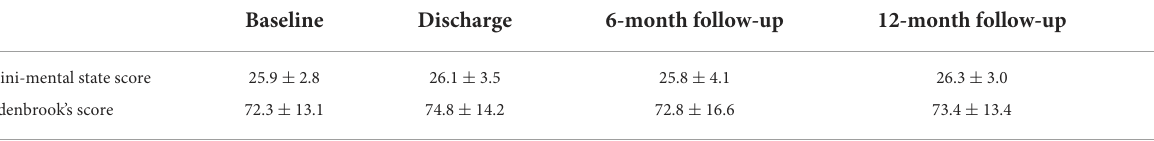
TABLE 6 Results of serial neurocognitive assessments.